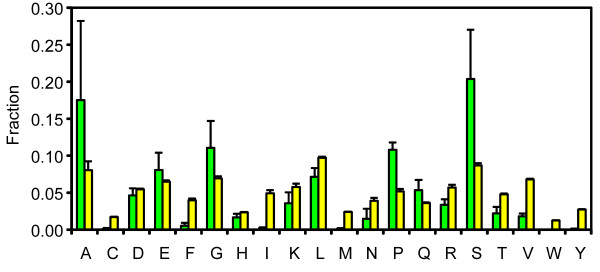
Residue composition in AARs and across the entire set of orthologs. The fractions of residues from AARs and from the entire set of orthologs are shown as green columns and yellow columns, respectively. Only positive error bars are shown.